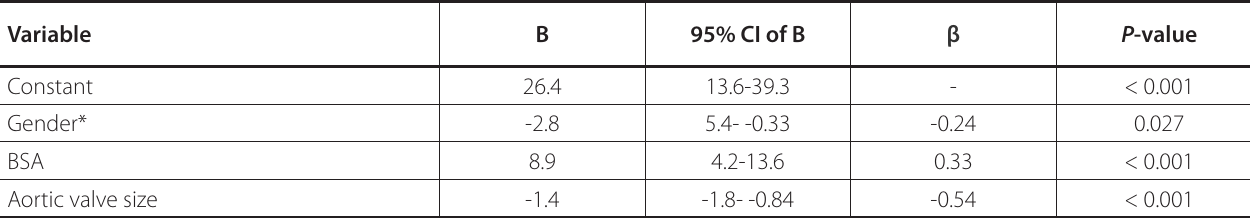
Table 5 . Multivariable linear regression of factors affecting the postoperative prosthetic aortic valve mean pressure gradient. Variable B 95% CI of B